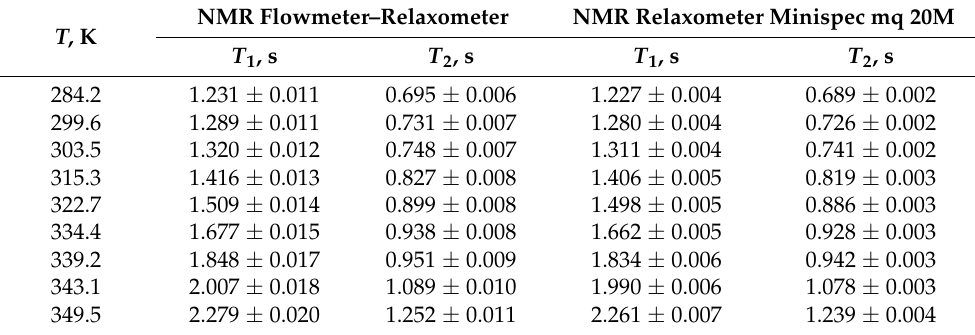
Table 2. The results of measuring the consumption q (m 3 /h) of a liquid mixture of feedwater with air bubbles and insoluble particles (with ionic conductivity (polymer) and electronic conductivity (bitumen)) at a temperature of T = 324.6 K in the pipeline of the experimental stand using various devices and a measured